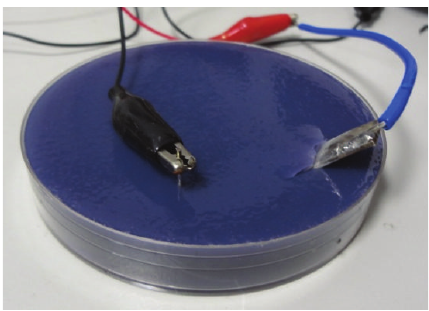
Figure 4: Preparing silver iodide by the conductivity method.